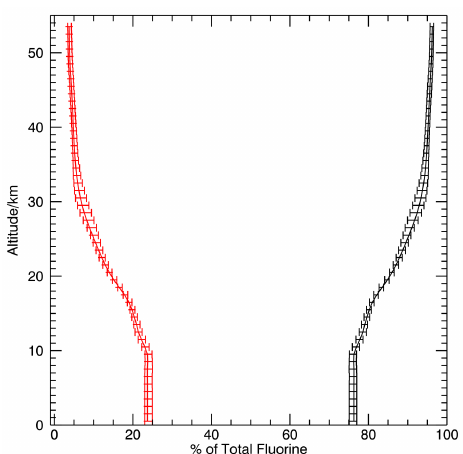
Table 8. The radiative efficiency – (RE) weighted trends in the total fluorine volume mixing ratio between 2004 and 2009. The weighted total fluorine budgets were also calculated without including CFCs and halons so that the impact of the Montreal Protocol on radiative efficiency-weighted fluorine could be quantified. Once more the er- ror presented here is the 1- σ error of a least squares